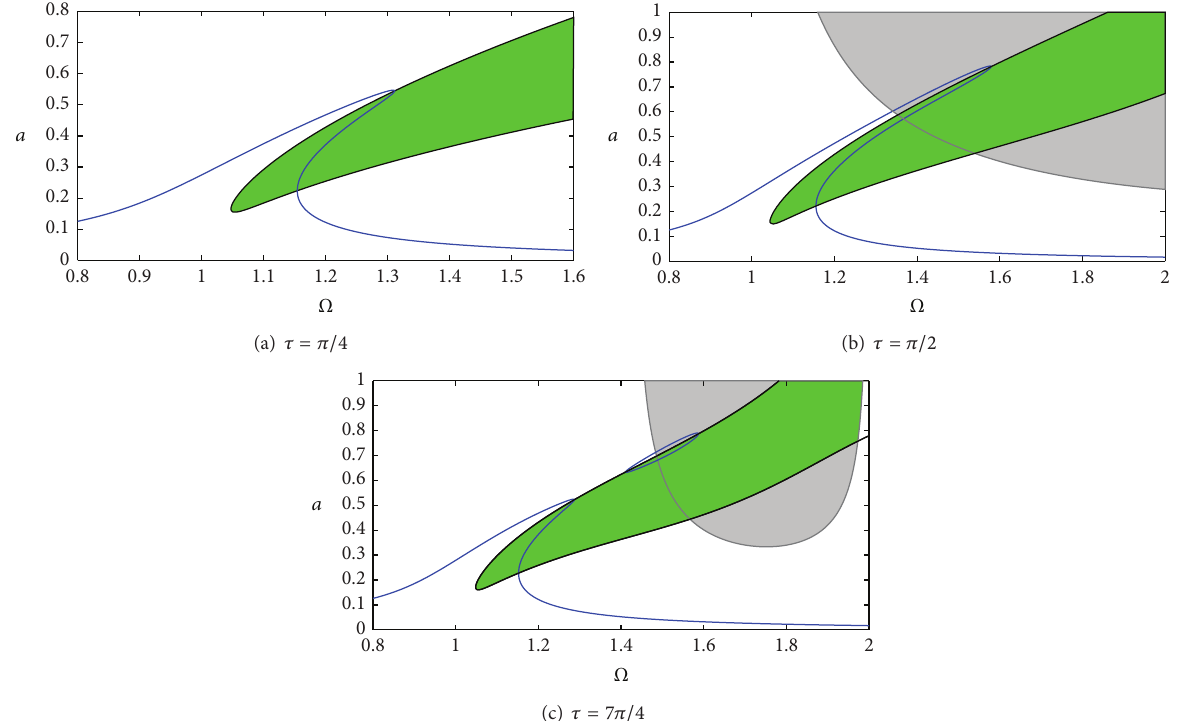
Figure 11: Stability boundary of the primary resonance for the controlled system with different time delay 𝜏 ( 𝜁 1 = 0.025 , 𝜁 3 = 0.05 , 𝑓 1 = 0.05 , 𝑘 = 1 , and ̂𝜆 = 0.4 ).